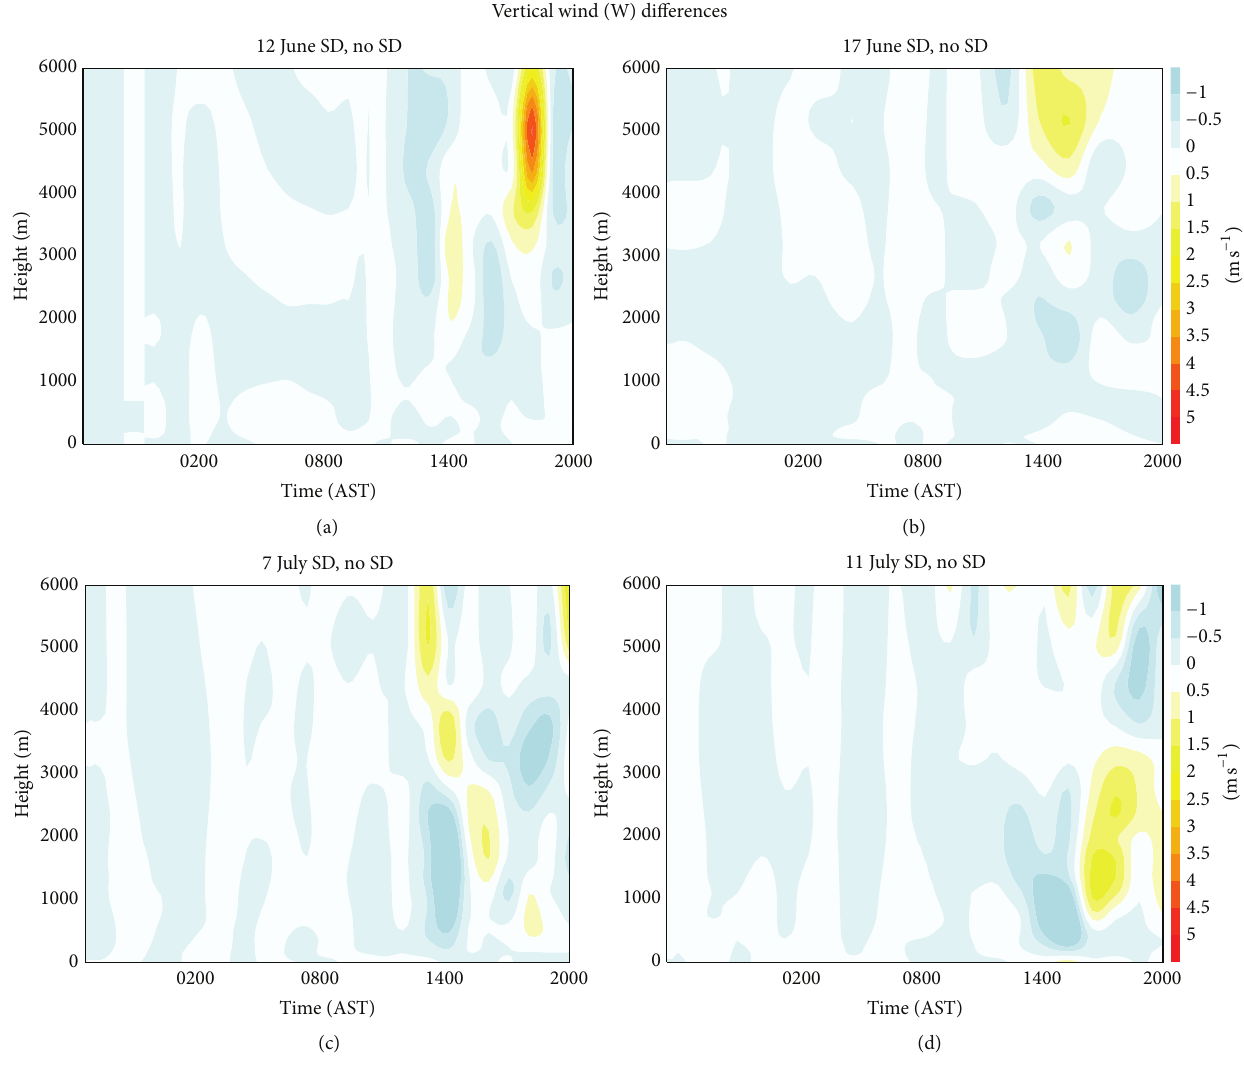
Figure 12: RAMS generated vertical wind (w) differences at Mayag¨uez between SD and no SD for 12 June 2014 (a), 17 June 2014 (b), 7 July 2014 (c), and 11 July 2014